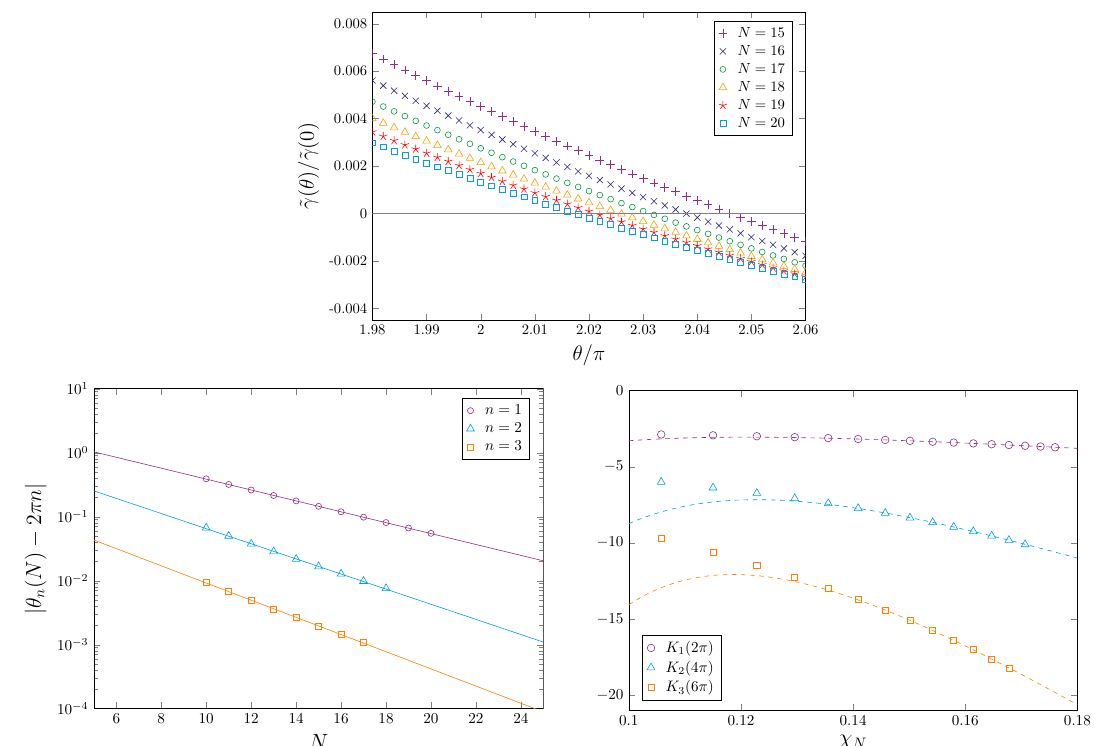
Figure 18 . (Top) The ratio ˜ γ trv ( θ ) / ˜ γ trv (0) for the trivial representation is plotted against θ in the U( N ) gauge theory with various N at λ = 3 . (Bottom-Left) The deviation of the zeroes θ n ( N ) from 2 πn is plotted against N for n = 1 , 2 and 3 in the log scale. The solid lines are fits to the exponential behavior | θ n ( N ) − 2 πn | ∼ A n e − B n N . (Bottom-Right) The quantity K n (2 πn ) is plotted for n = 1 , 2 and 3 against χ N . The dashed lines are fits to the behavior K n (2 πn ) = b n χ N + c n + d n /N 2